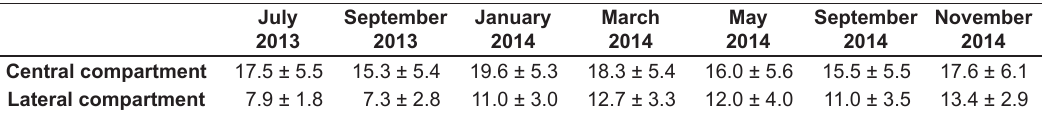
Figure 1. River basin of Rio de Contas and sampling sites in the reservoir Barragem da Pedra, Jequié, Bahia. P1, P2, P4, and P5 are sites in the lateral compartment while P3, P6, P7, and P8 are located in the central compartment. Table 1. Mean depth (m) (± standard deviation) of the compartments sampled in the reservoir Barragem da Pedra between July 2013 and November